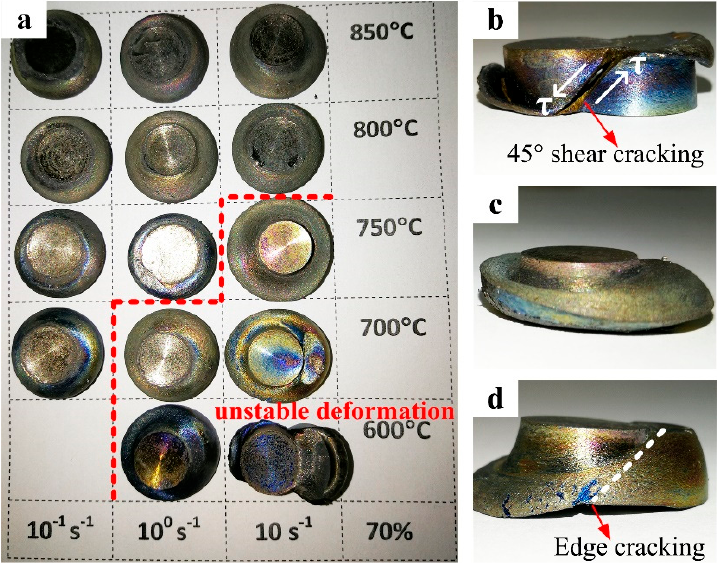
Figure 3. Macroscopical images of the hot-compressed PM Ti-5553 specimens, under various conditions at: ( a ) 600 °C–800 °C/0.1 s − 1 –10 s − 1 ; ( b ) 600 °C/10 s − 1 ; ( c ) 600 °C/1 s − 1 and ( d ) 700 °C/10 s − 1 .